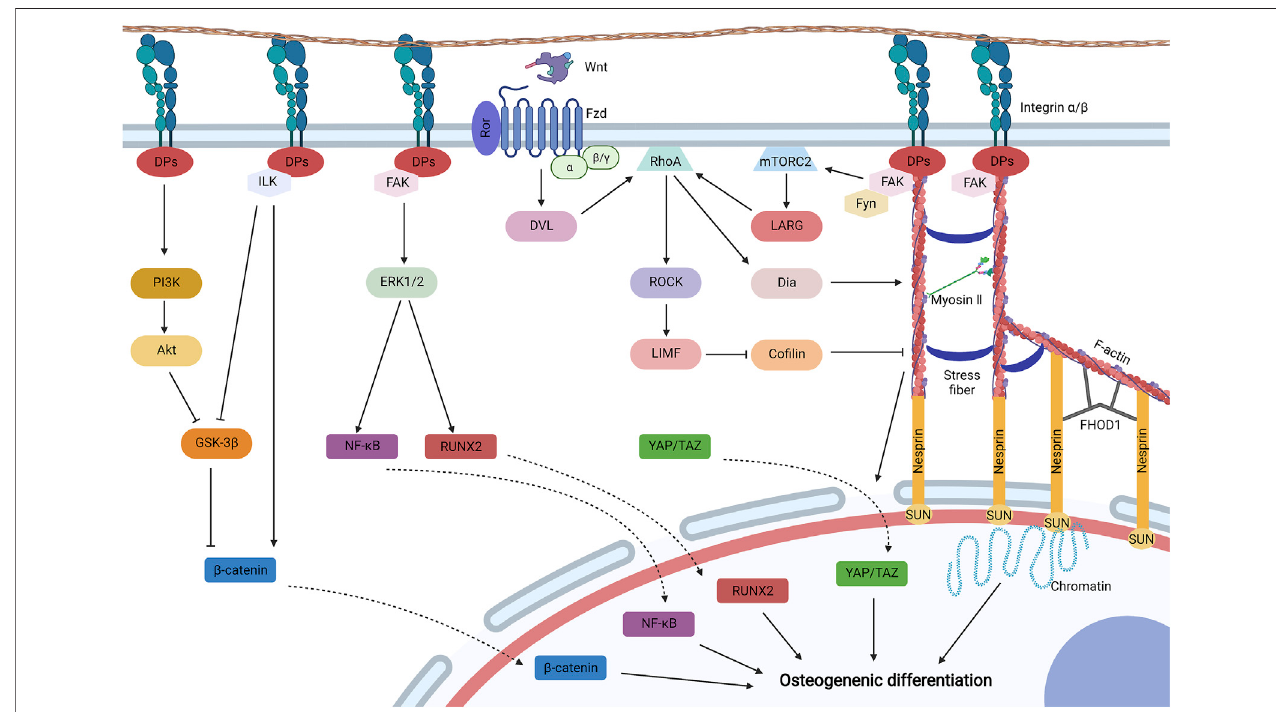
FIGURE 3 | Self-biophysical transduction for mesenchymal stem cell (MSCs) osteogenesis, including biophysical sensitive ion channels, primary cilium, and biophysicalsensitive.WhenMSCsareexposedtobiophysicalstimuli,variousbiophysicalsensitiveionchannelsontheplasmamembranemaybeactivatedforthein fl ux ofCa 2+ ,whichincludevoltage-gatedcalciumchannels(VGCC),stretch-activatedcalciumchannels(SACCs),Piezo,transientreceptorpotentialvallanoid1(TPRV1),and TPRV4.TPRV4 islocatedathigh-strain regions,especiallyprimarycilium.BiophysicalstimulicanalsostimulatethereleaseofCa 2+ fromtheendoplasmicreticulum to the cytoplasm by uncanonical Wnt-Ca2+ signaling. In speci fi c, Wnt ligand binds to the Frizzled (Fzd)/receptor tyrosine kinase-like orphan receptor (Ror) complex to activate Dishevelled (Dvl), which then activates phospholipase C (PLC) to produce inositol 1,4,5-trisphosphate (IP3). IP3 could activate IP3 receptor for the release of Ca 2+ from the endoplasmic reticulum. The increased Ca 2+ in the cytoplasm may promote osteogenic differentiation by activating calcineurin/Nuclear Factor of Activated Cells(NF-AT)signalingandinitiatingextracellularsignal-relatedkinase1/2(ERK1/2)byfocaladhesionkinase(FAK)toregulatetheactivityof β -catenin.Biophysicalstimuli could regulate the primary cilium containing intra fl agellar transport protein 88 (IFT88) for MSC osteogenesis by regulating length or Gpr161/adenylyl cyclase 6 (AC6) signaling, and the activation of AC6 promotes the synthesis of cyclic adenosine 3 ′ ,5 ′ -monophosphate (cAMP), which then promotes the osteogenic differentiation of MSCs by Hedgehog (Hb) signaling and proteinkinase A (PKA) signaling. Biophysical stimuli could also promote some long noncoding RNAs (lncRNAs) to inhibit some microRNAs (miRNAs) for osteogenic differentiation. Created with